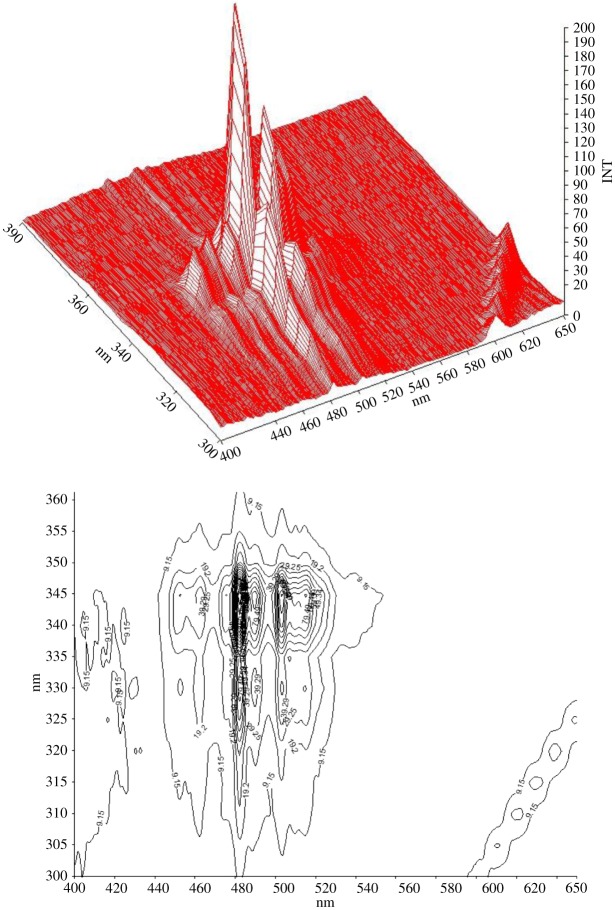
Effect of choice of Δλ on LOS (2 μg ml−1).